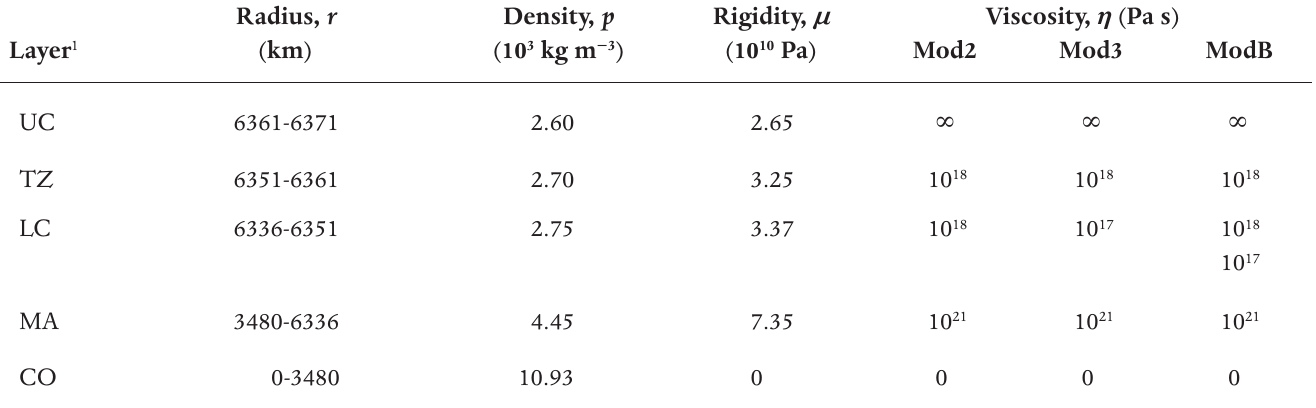
Table 2. Mod2, Mod3, ModB model parameters used for the 2009 L'Aquila earthquake ( 1 UC: Upper crust, TZ: Transition zone, LC: Lower crust, MA: Mantle, CO: